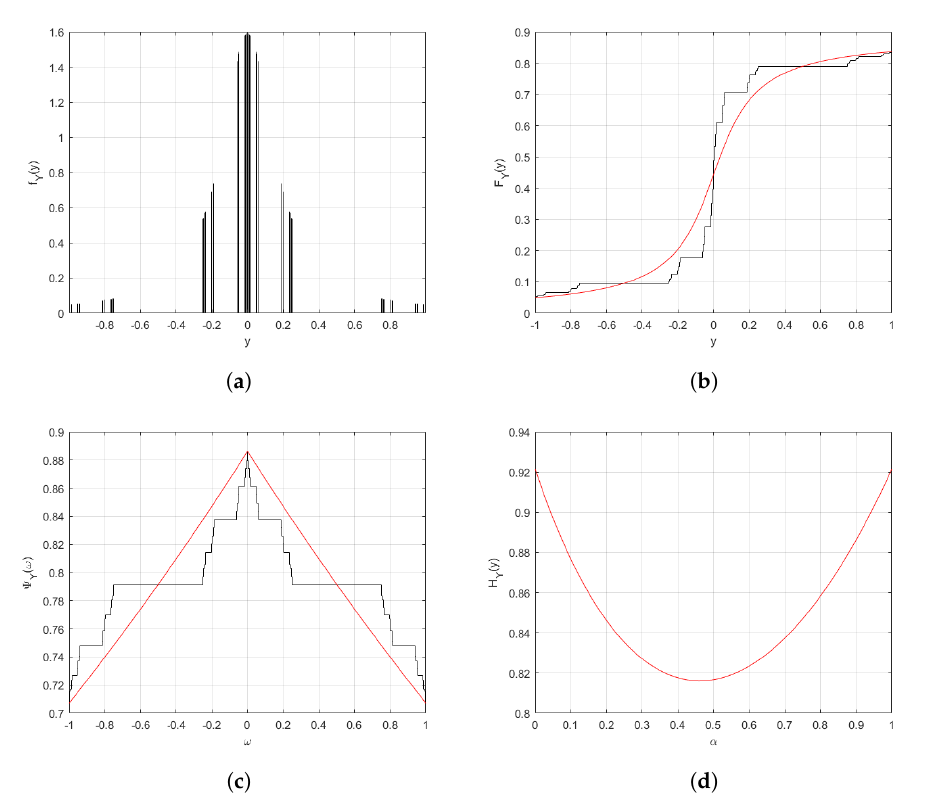
Figure 2. Figures for Example 1. ( a ) Probability density function of a fractal Cauchy random variable with α = 0.5, β = 2, a = 0.2; ( b ) distribution function of a fractal Cauchy random variable with α = 0.5, β = 2, a = 0.2; ( c ) characteristic function of a fractal Cauchy random variable with α = 0.5, β = 2, a = 0.2; ( d ) entropy of a fractal Cauchy random variable with a =